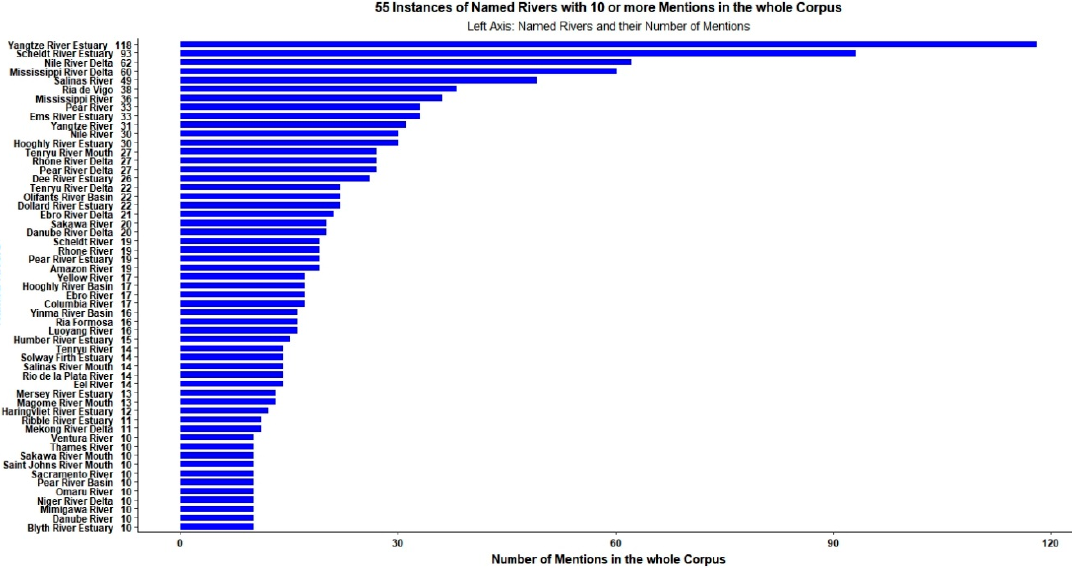
Figure 2. Designations and number of mentions of the 55 named rivers whose occurrence frequency was higher than 9.